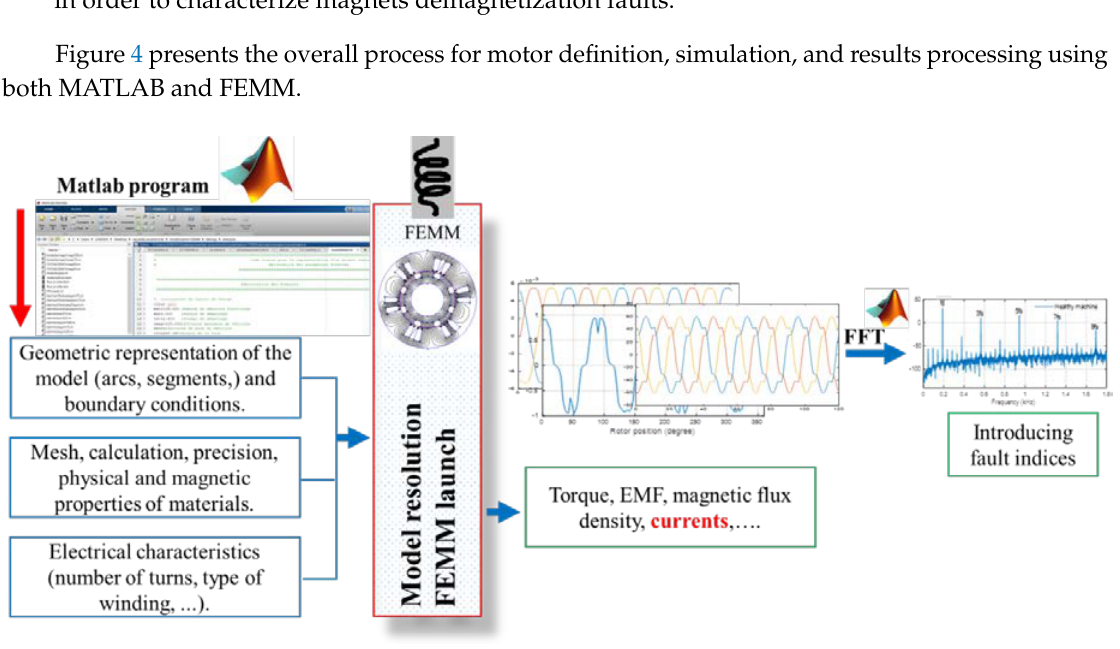
Figure 4. Permanent magnet synchronous machines (PMSMs) demagnetization fault detection procedure.